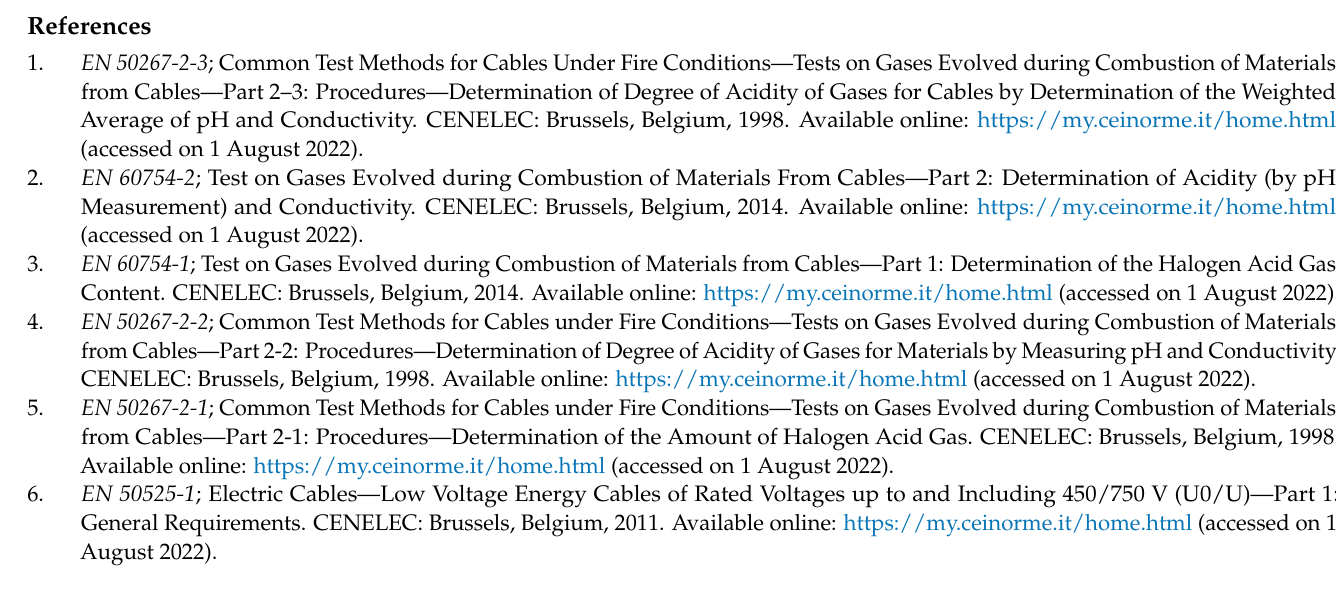
Figure A13. A schematic diagram of the testing process and main conditions .